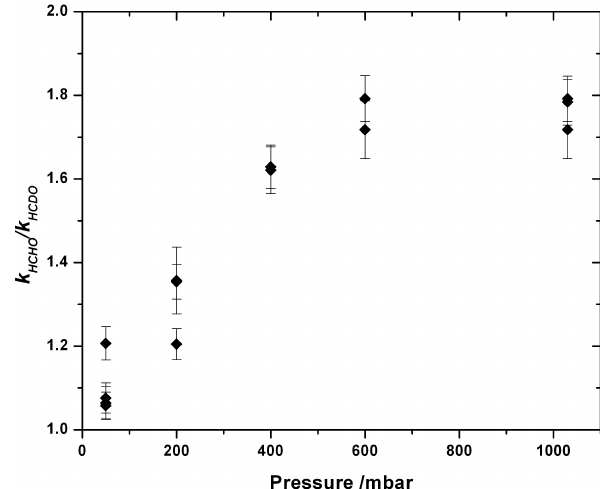
Fig. 3. Relative dissociation rate of formaldehyde, k HCHO / k HCDO , as a function of pressure. The same data are as presented in Table 2. Error bars are based on the uncertainty in the determination of the slope of the relative rate plot with an additional 3% error to account for possible uncertainties in reference